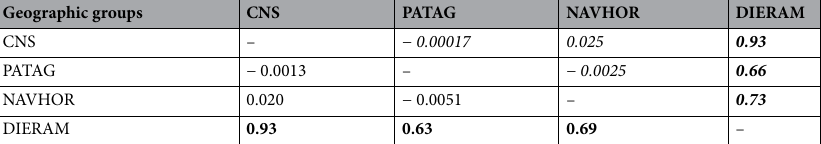
Table 3. Measures of genetic distance based on mtDNA between Aphrastura geographic groups. CNS Center, north and south, PATAG Patagonia (Chiloé to Tierra del Fuego), NAVHOR Navarino and Horn islands, DIERAM Diego Ramírez. Shown are pairwise F ST values (above the diagonal, in italics) and Ф ST values (below the diagonal). Statistically significant values are shown in bold (all p < 0.005).